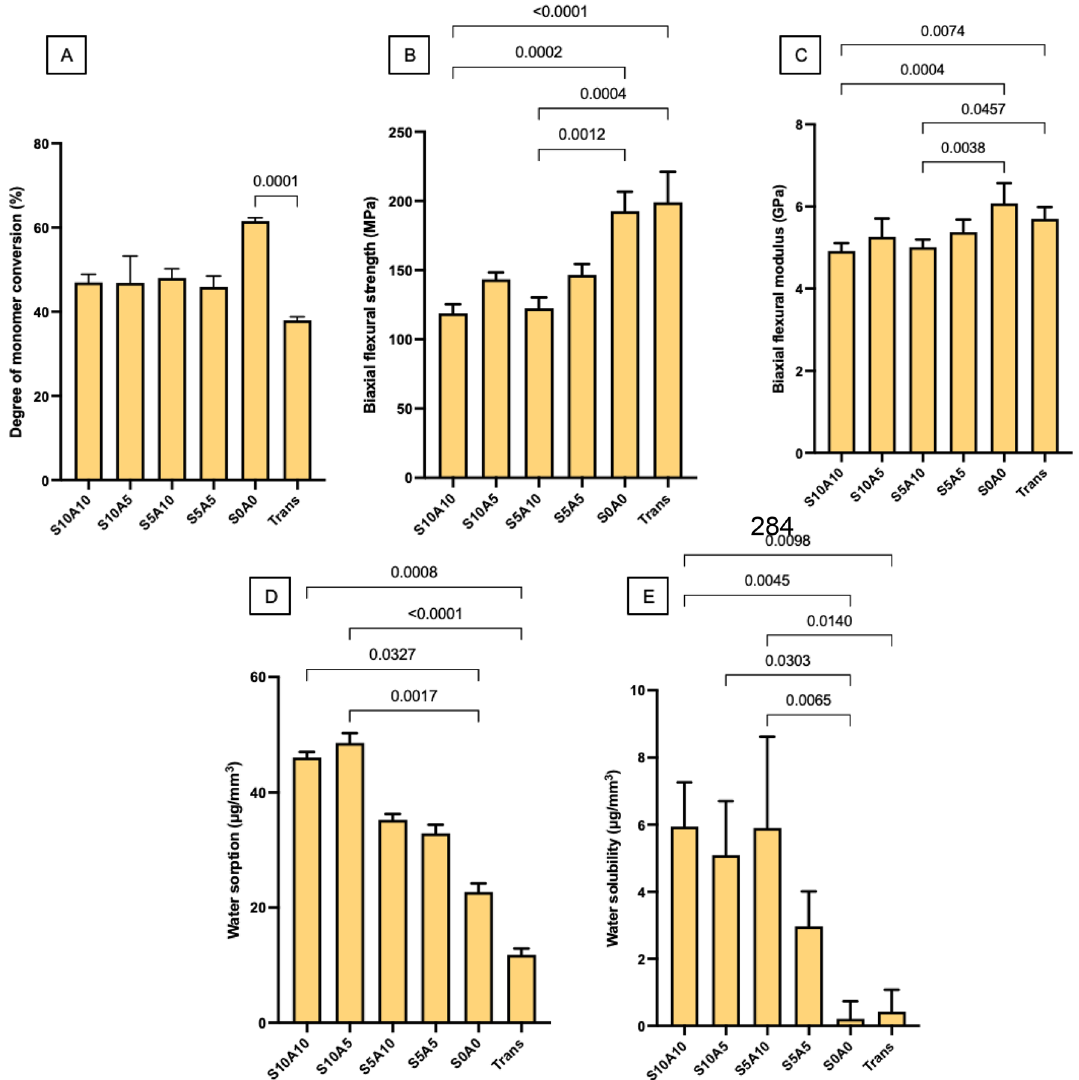
Figure 2. ( A ) Degree of monomer conversion after light-curing for 20 s (mean ± SD, n = 5). ( B ) Biaxial flexural strength (BFS) and ( C ) biaxial flexural modulus (BFM) after immersion in deionized water for 24 h (mean ± SD, n = 8). ( D ) Water sorption and ( E ) water solubility after immersion in deionized water for 4 weeks (mean ± SD, n = 6). The lines indicate p < ( p < 0.05). The factorial analysis indicated that an increase in Andro from 5 to 10 wt% increased water solubility by 55.97 ± 55.91%, while the effect of Sr/CaP was minimal. Enamel shear bond strength (SBS) and adhesive remnant index (ARI score).